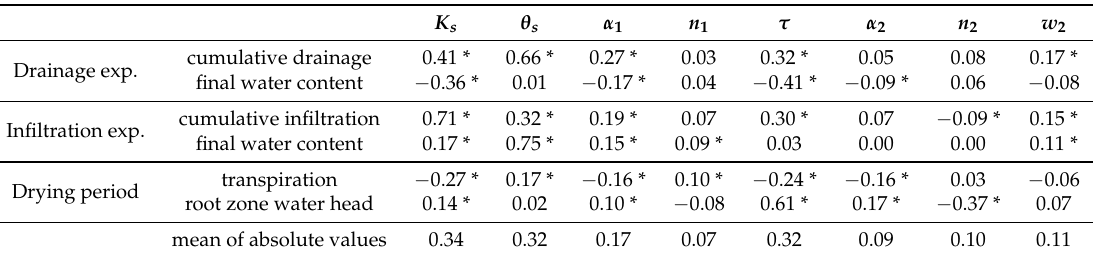
Table 6. Pearson correlation coefficients (R) of simulation results with parameters for hydraulic soil properties functions. * indicates significant relationships, α =